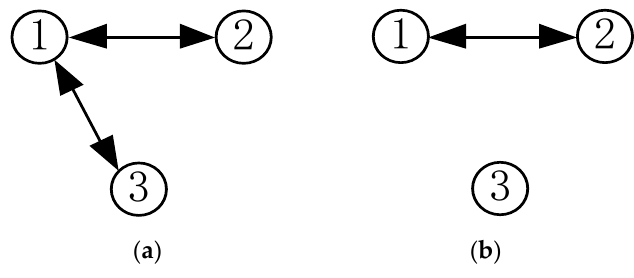
Figure 2. Different power transmission type in three-port active bridge (TAB).